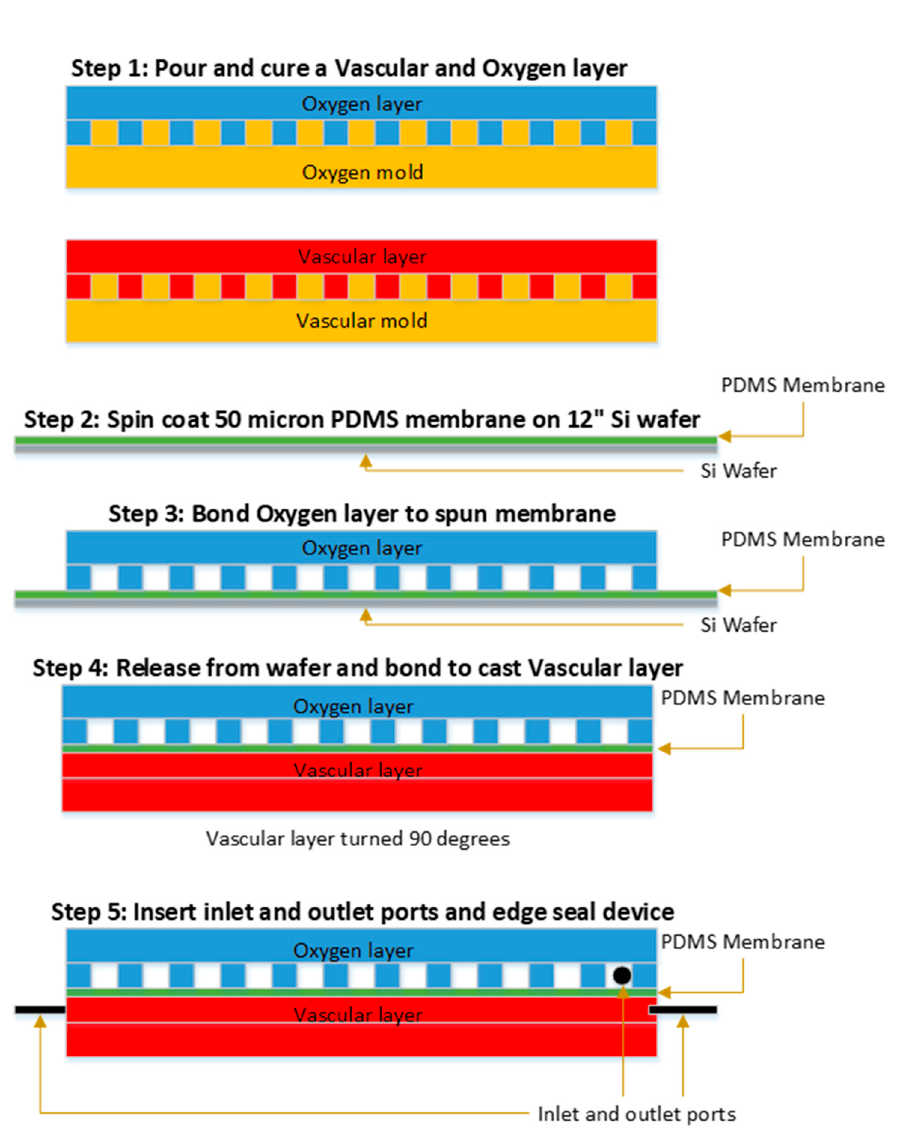
Figure 2. Fabrication process for microfluidic oxygenator. Master molds for vascular and oxygen are shown in gold, while oxygen layers are shown in blue and vascular layers in red. The NuSil membrane is shown in green. Step 1: Cast NuSil vascular and oxygen layers against master molds, creating open channels in the NuSil layers via microreplication from the gold-coated micromachined molds. Step 2: Spin cast Nusil membrane against a polished silicon wafer. Step 3: Bond oxygen layer to spin-cast membrane. Step 4: Bond vascular layer to other side of membrane, creating a single layer sandwich structure for gas transfer. Step 5: Insert tubing connections (shown at left and right in the oxygen layer, in and out of plane in the vascular layer) and apply edge seal to the assembled sandwich structure.